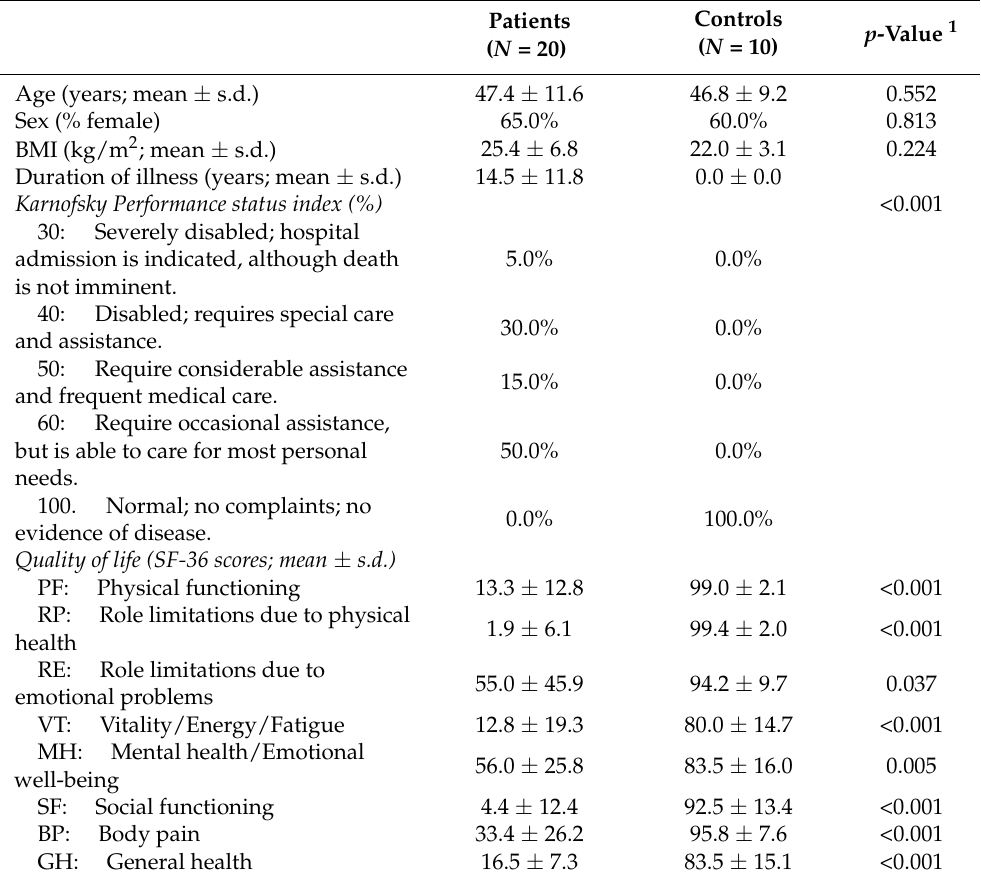
Table 1. Demographics and quality of life of severe myalgic encephalomyelitis/chronic fatigue syndrome (ME/CFS) patients and healthy